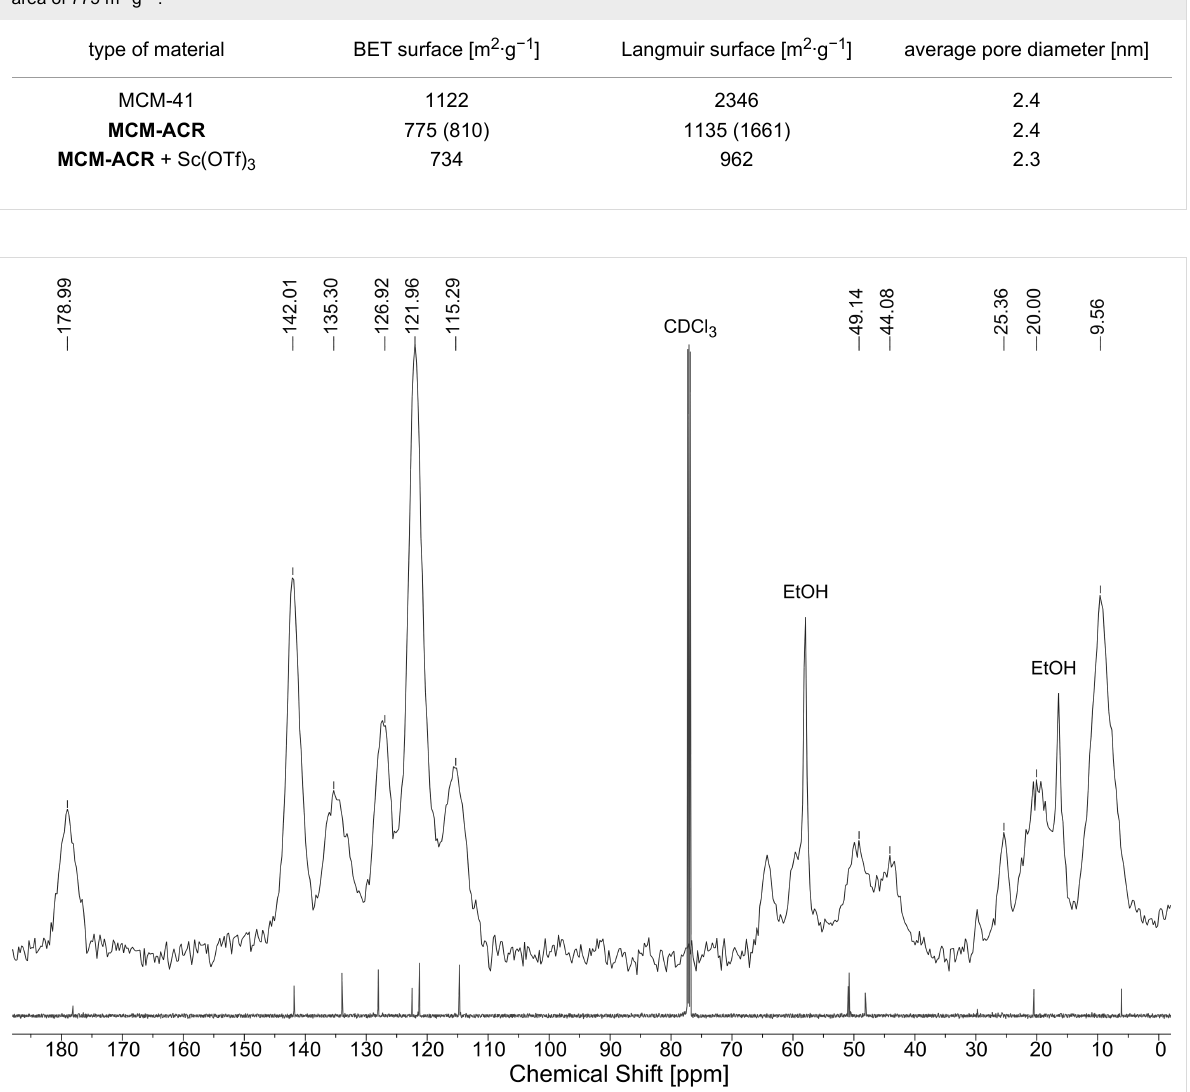
Table 1: BET and PSD date of different obtained mesoporous siliceous materials. In the case of MCM-ACR , two batches have been prepared with well reproducible outcomes (second batch in parentheses). The modified MCM-ACR sample was prepared from the first batch with a BET surface area of 775 m 2 ·g − 1 .